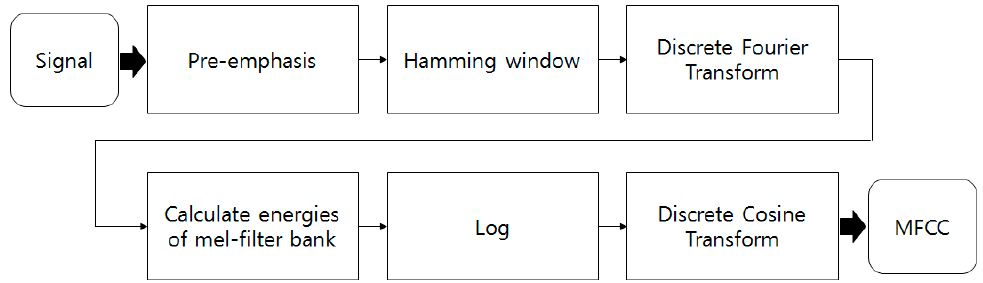
Figure 6. Process used to calculate MFCC.